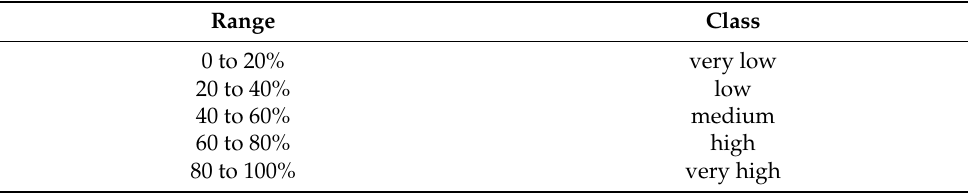
Table 3. FAIR Classification